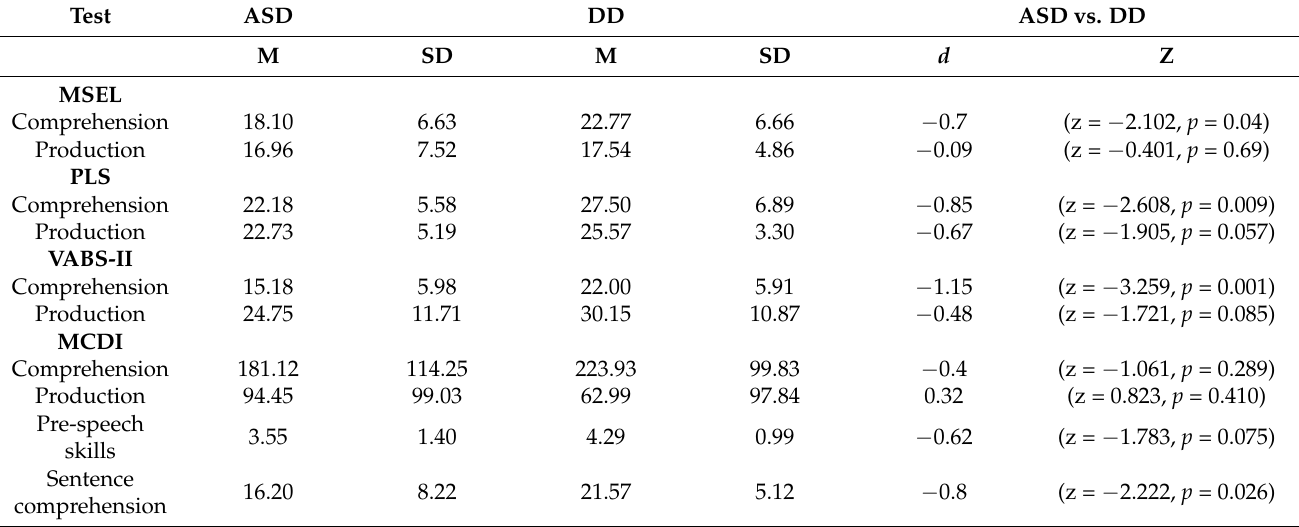
Table 4. Descriptive statistics corresponding to direct measures in language comprehension and production in MSEL, VABS-II, PLS, and MCDI and differences between